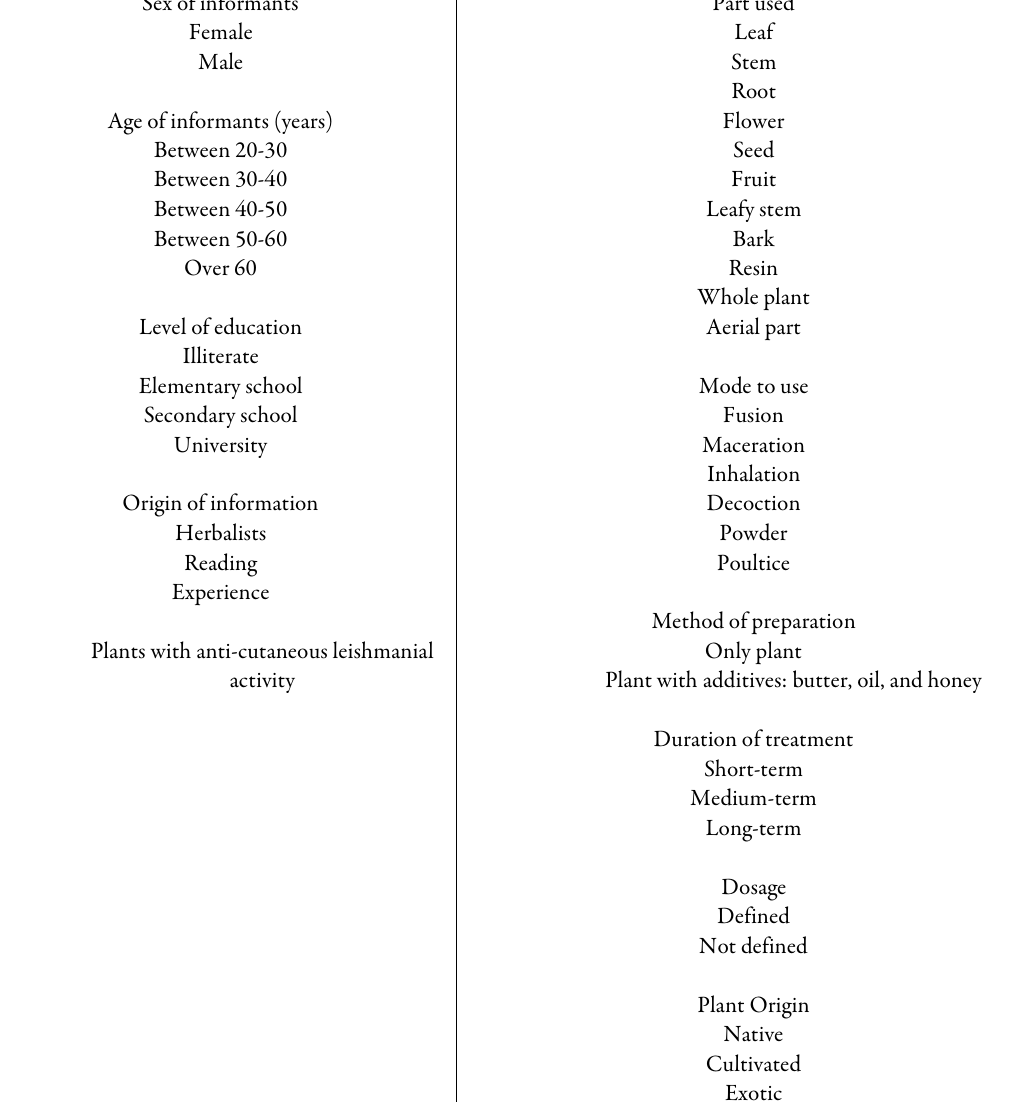
Table 1. Questionnaire: Medicinal plants with anti-cutaneous leishmanial